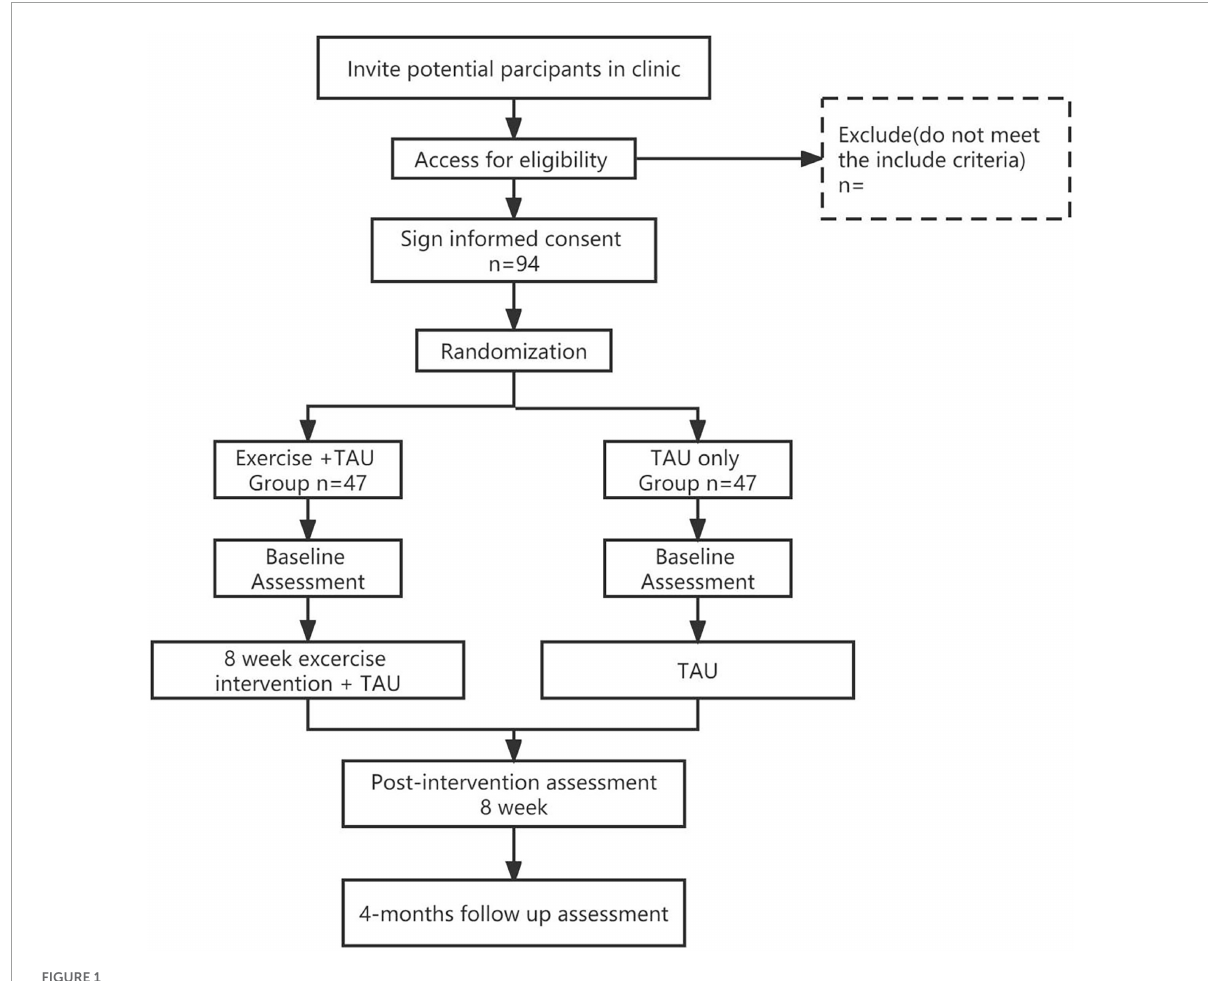
FIGURE1 Flow of precedure. TAU, Treatment as